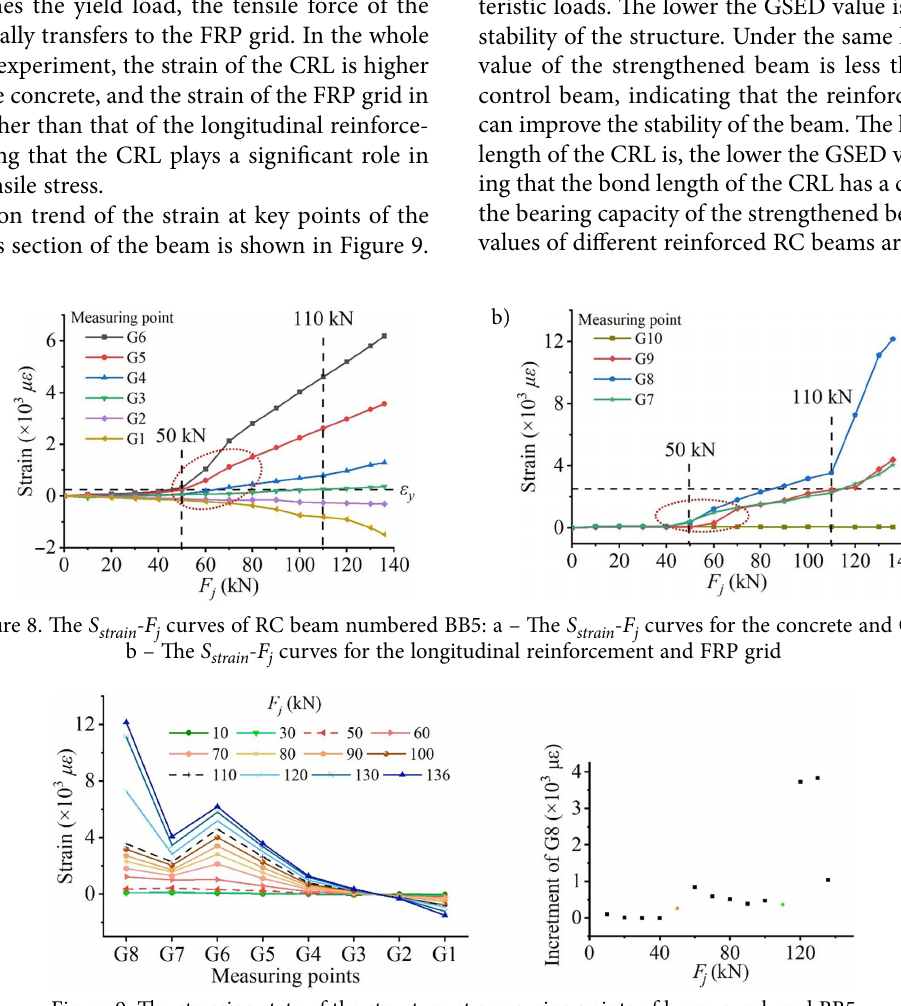
Figure 9. The stressing state of the structure at measuring points of beam